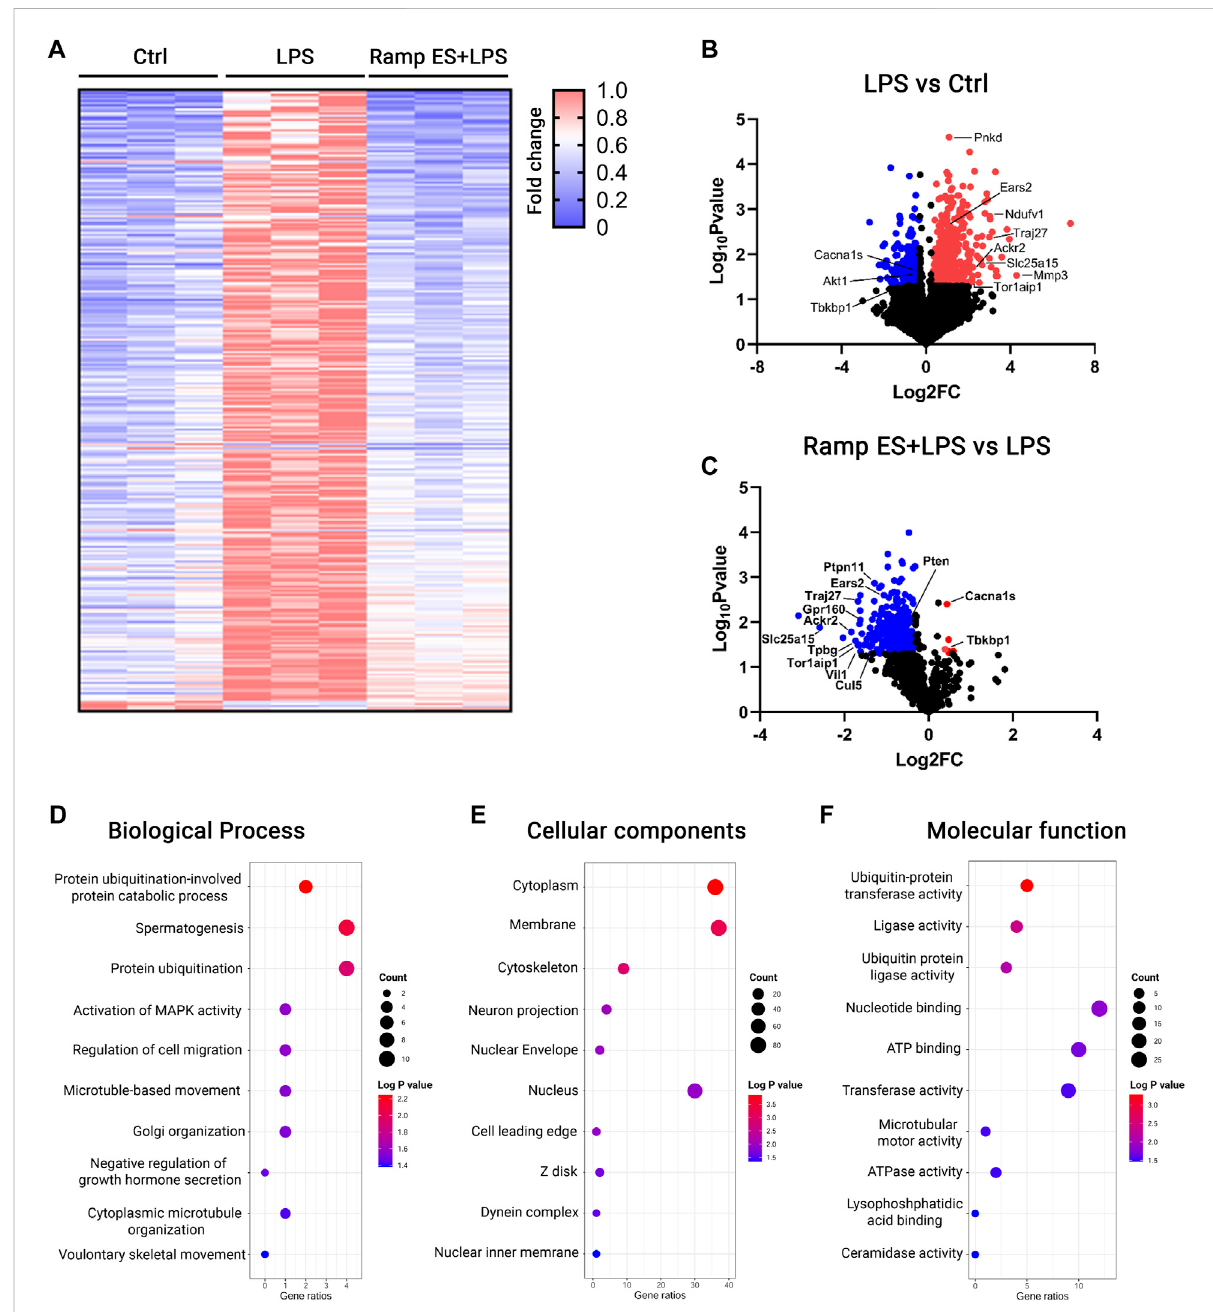
FIGURE 5 RNA-seq analysis for the transcriptome pro fi les of LPS-challenged BV-2 cells with or without ES-treatment. (A) Heatmap of DEGs in Control, LPS, and Ramp ES + LPS treated groups; the values were normalized as fold change over the control group. (B,C) Volcano plots of Control vs LPS (B) and LPSvsRamp ES + LPS (C) . (D – F) Dot plotsoftop tenGO termsthrough analysis of ES-suppressedgenesthat weredivided into thecategoriesof Biological process (D) , Cellular components (E) , and Molecular function (F)